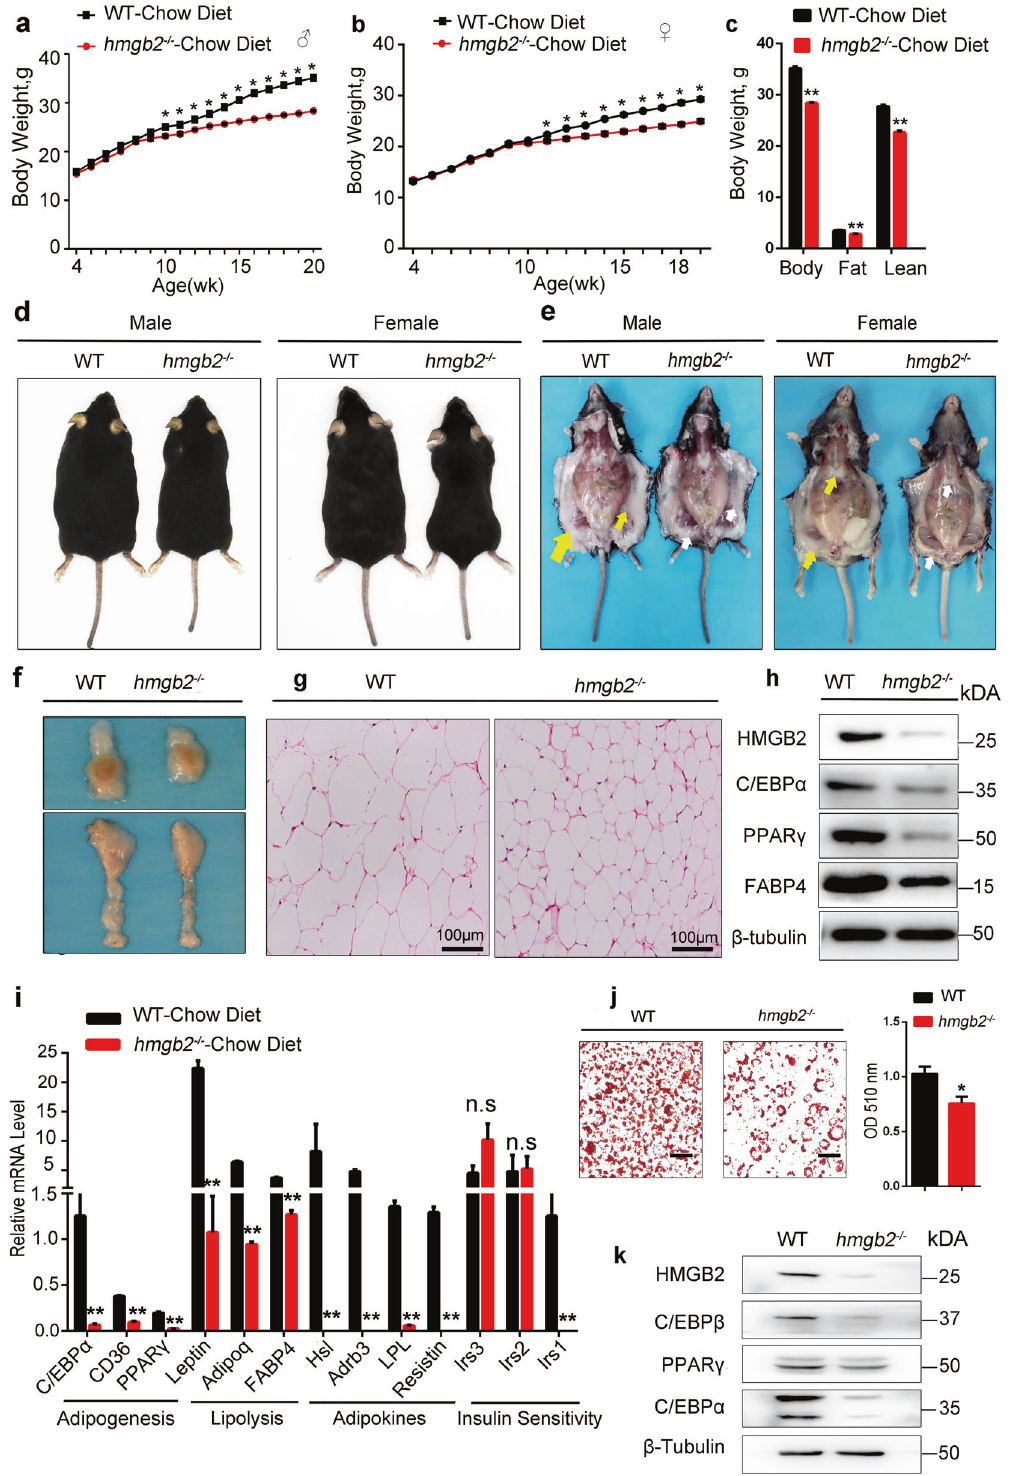
Fig. 3 Deletion of HMGB2 suppresses adipogenesis in vivo. a , b Representative body weight diagram of male ( n = 5) and female mice ( n = 6). c The weight of Body, fat tissue, and lean of hmgb2 − / − and WT mice. n = 5, male, 12 weeks old. d The phenotype of WT and hmgb2 − / − mice at 12 weeks postnatal. e Dissection images. Yellow arrow: ingWAT in WT mice; white arrow: ingWAT in hmgb2 − / − mice. f Anatomical images of eWAT (upper picture) and ingWAT (lower picture). g H&E staining of ingWAT slides. Scale bar: 100 μ m. h Western blot analysis of protein level for adipogenic maker genes. Protein was extracted from ingWAT of male mice ( n = 5). i qPCR analysis for genes related to adipogenesis, lipolysis, adipokines, and insulin in ingWAT. j Oil Red-O staining of SVFs derived from ingWAT (left) and OD measurements of stained cells (right). k Western blot analysis of protein levels for adipogenic marker genes in SVFs. ( i : mean values ± s.e.m. ** P < 0.01; * P < 0.05).